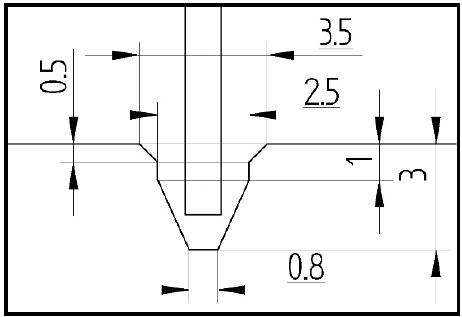
Figure 7. The support of column edges (shape of groove).